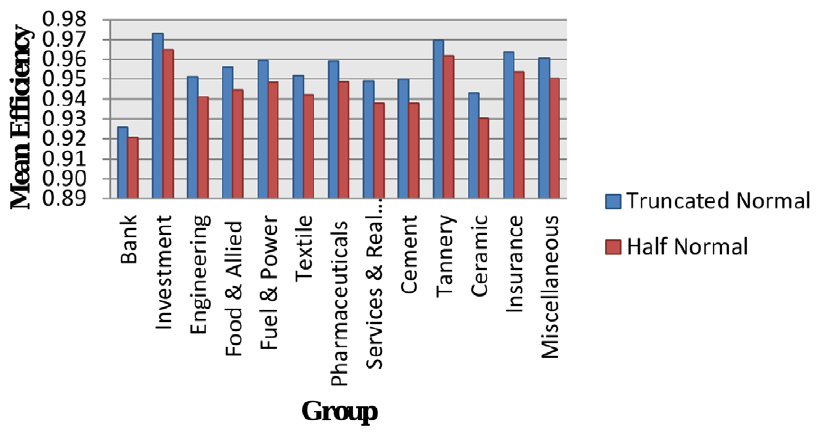
Figure 2. Group-wise mean efficiency by distribution with time-variant.